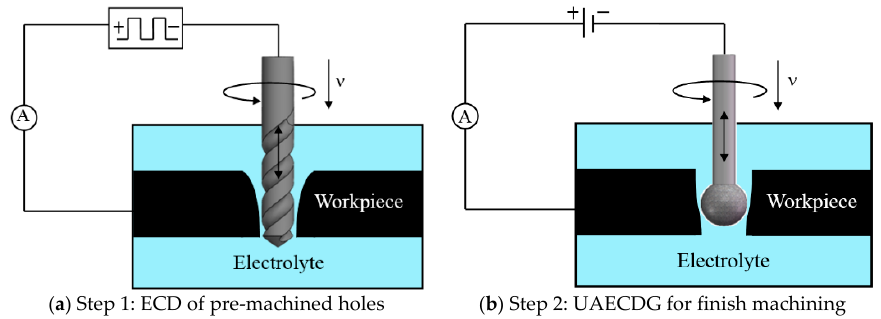
Figure 3. Schematic diagram of machining process.